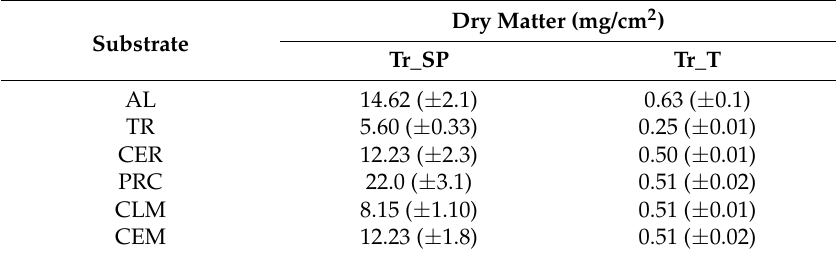
Table 2. Dry matter (mg/cm 2 ) of the SP and T layers absorbed by the